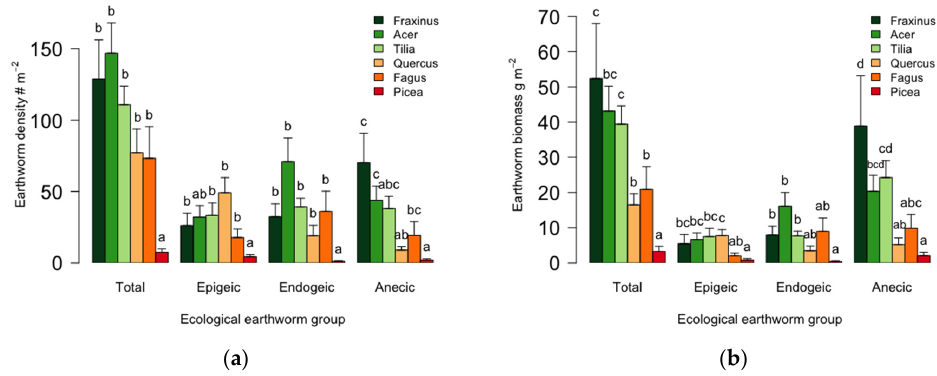
Figure 2. Density ( a ) and biomass ( b ) of total, epigeic, endogeic and anecic earthworms (mean + standard error). The tree species were sorted according to decreasing soil pH-KCl (0–5 cm). Significant differences between tree species within each earthworm group are indicated with letters (Tukey post-hoc tests on generalized linear multilevel (glmmADMB) models, 1|Site).